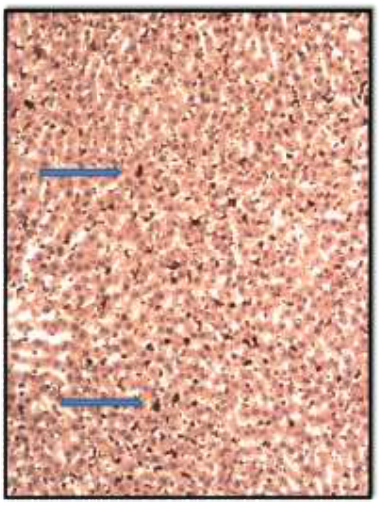
Figure 4b: Photomicrograph of Sudan black stained 5 µm thick frozen section of liver showing multiple fat droplets in hepatocytes of rat on a high-fat diet (group 2) at ×400.